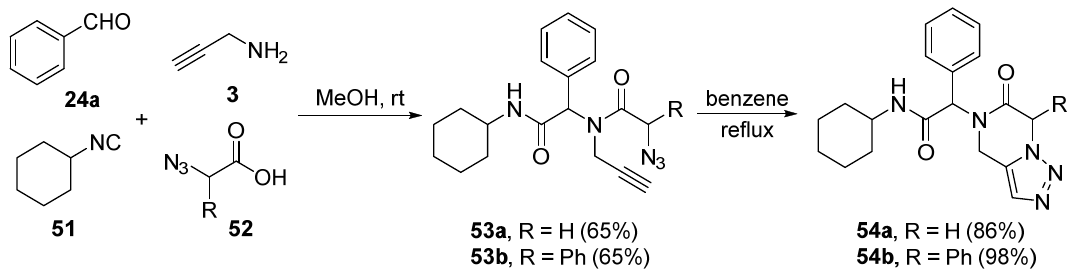
Figure 2. Ugi dipeptide products that failed to undergo IAAC.